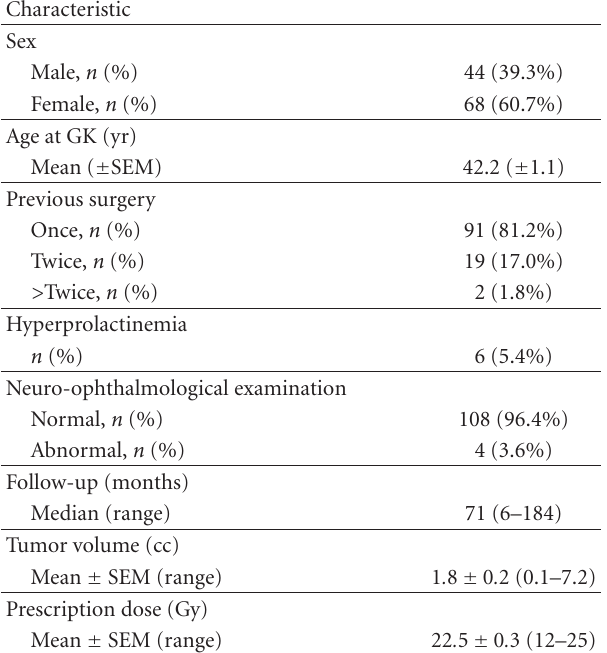
Table 1: General characteristics of the